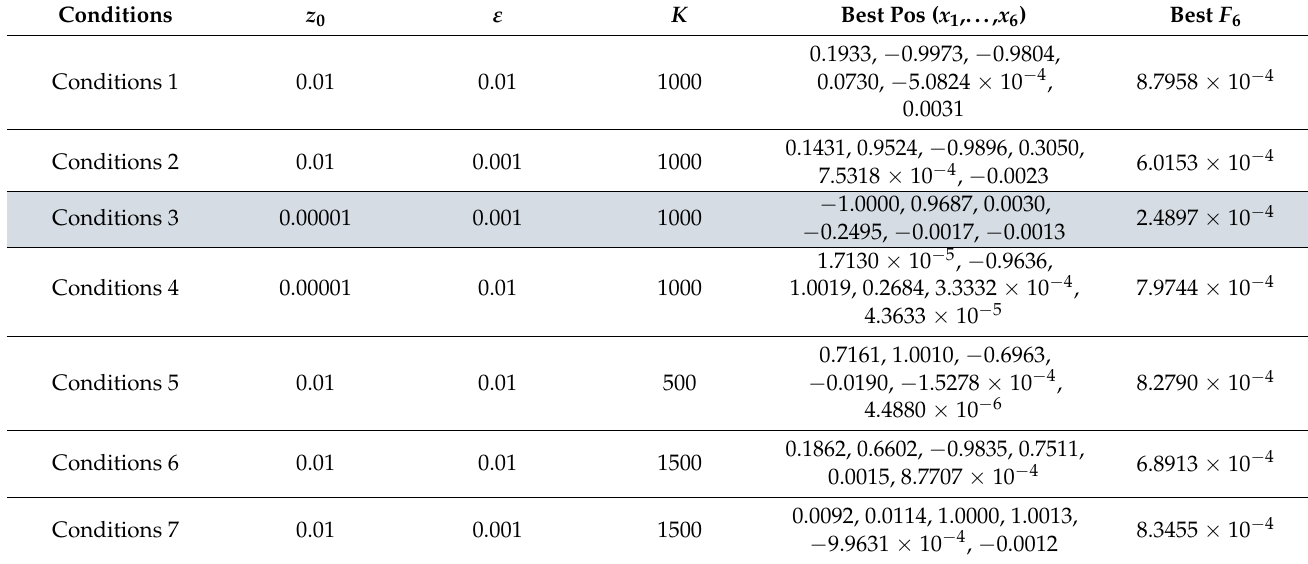
Table 9. Results of Case 6: F 6 at different conditions.